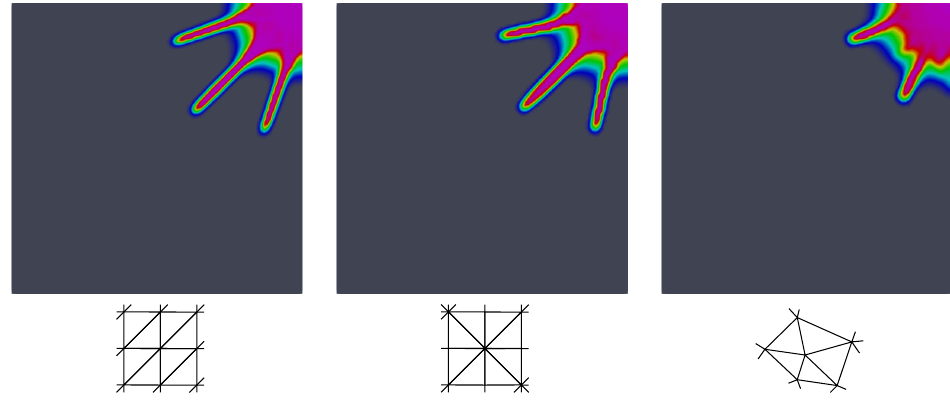
Figure 14. Damage distribution for three different